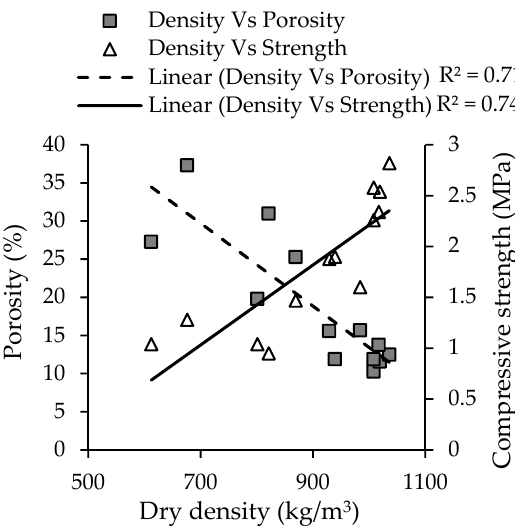
Figure 8. Influence of liquid to solid ratio and mix duration on density of alkali-activated MIBA (adapted from Chen et al. [92]).